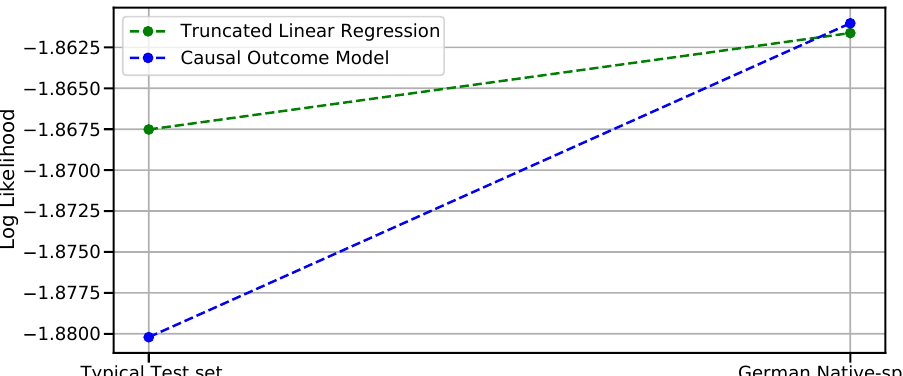
Figure 6. PLL for the Truncated Bayesian Linear Regression and the Causal Outcome Model on a “typical” test set (30% of randomly selected subjects) vs. a test set composed of uncommon subjects (i.e., German native speaking